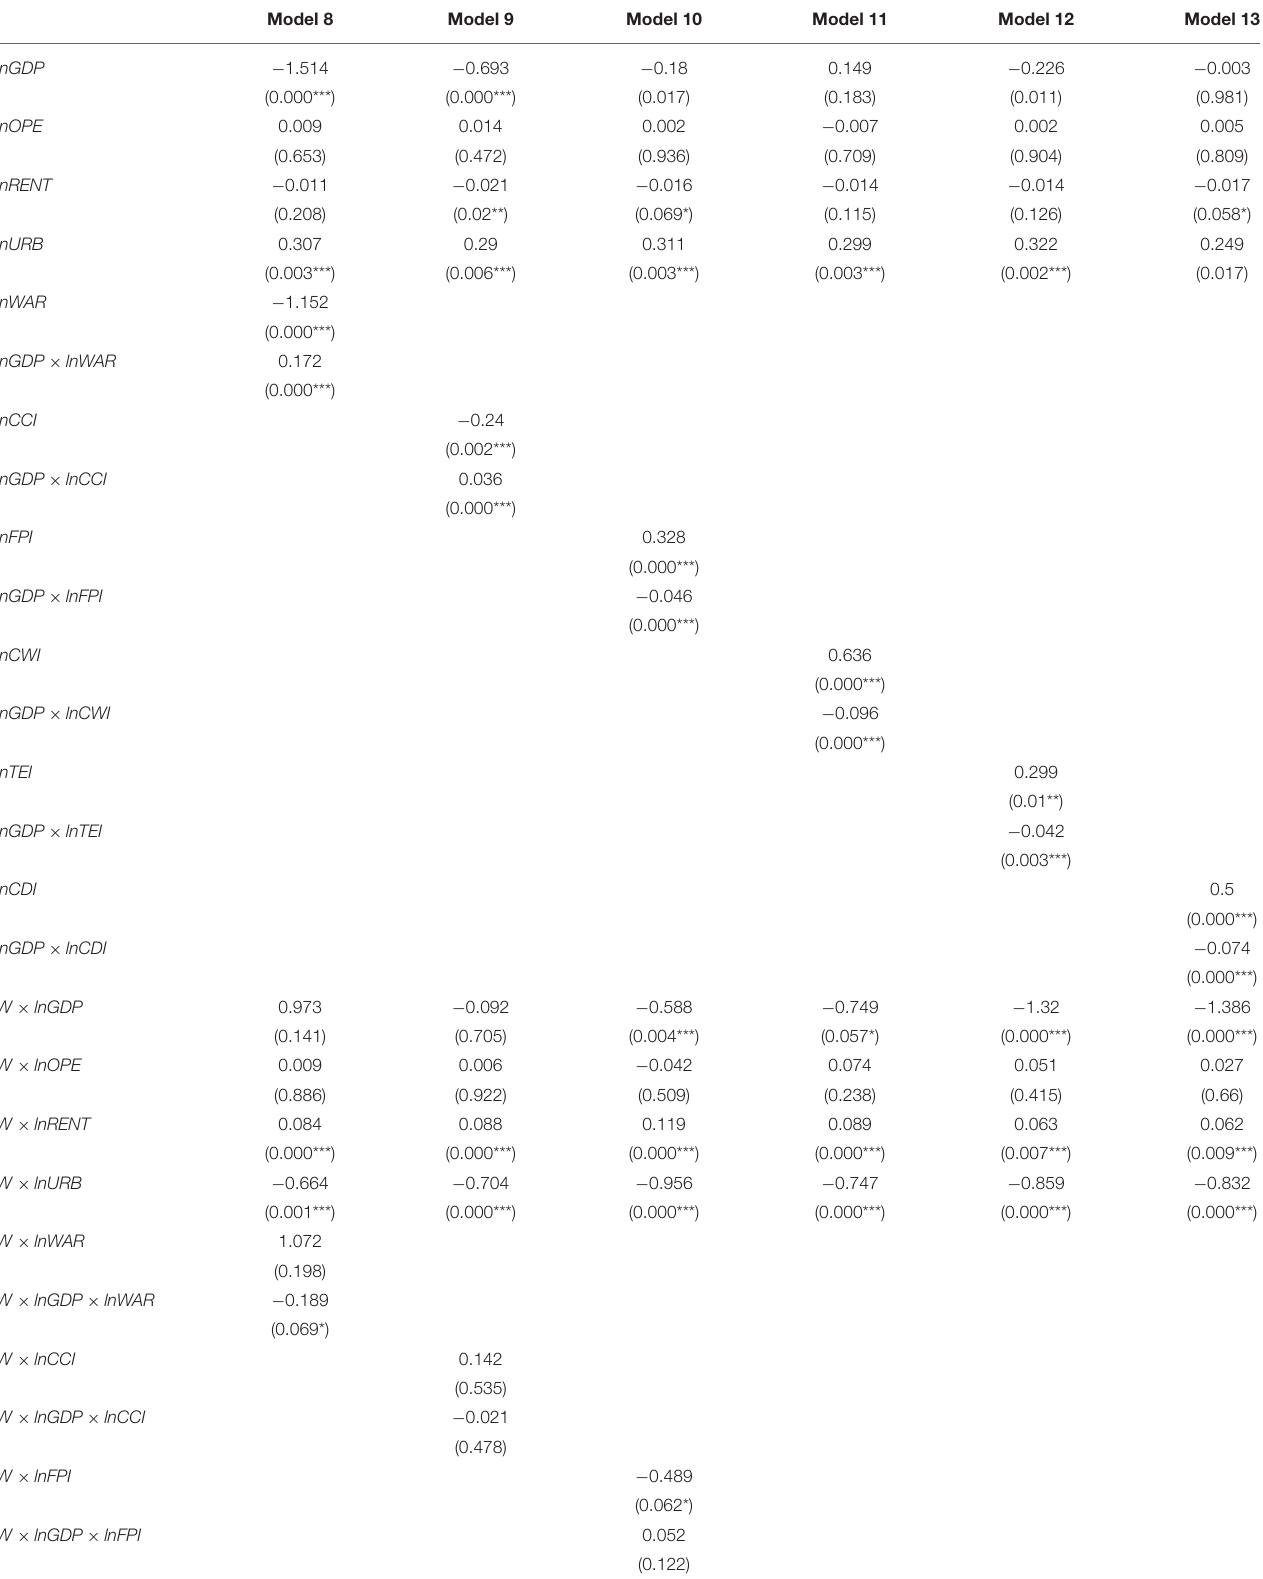
TABLE 6 | Estimation results for Equation